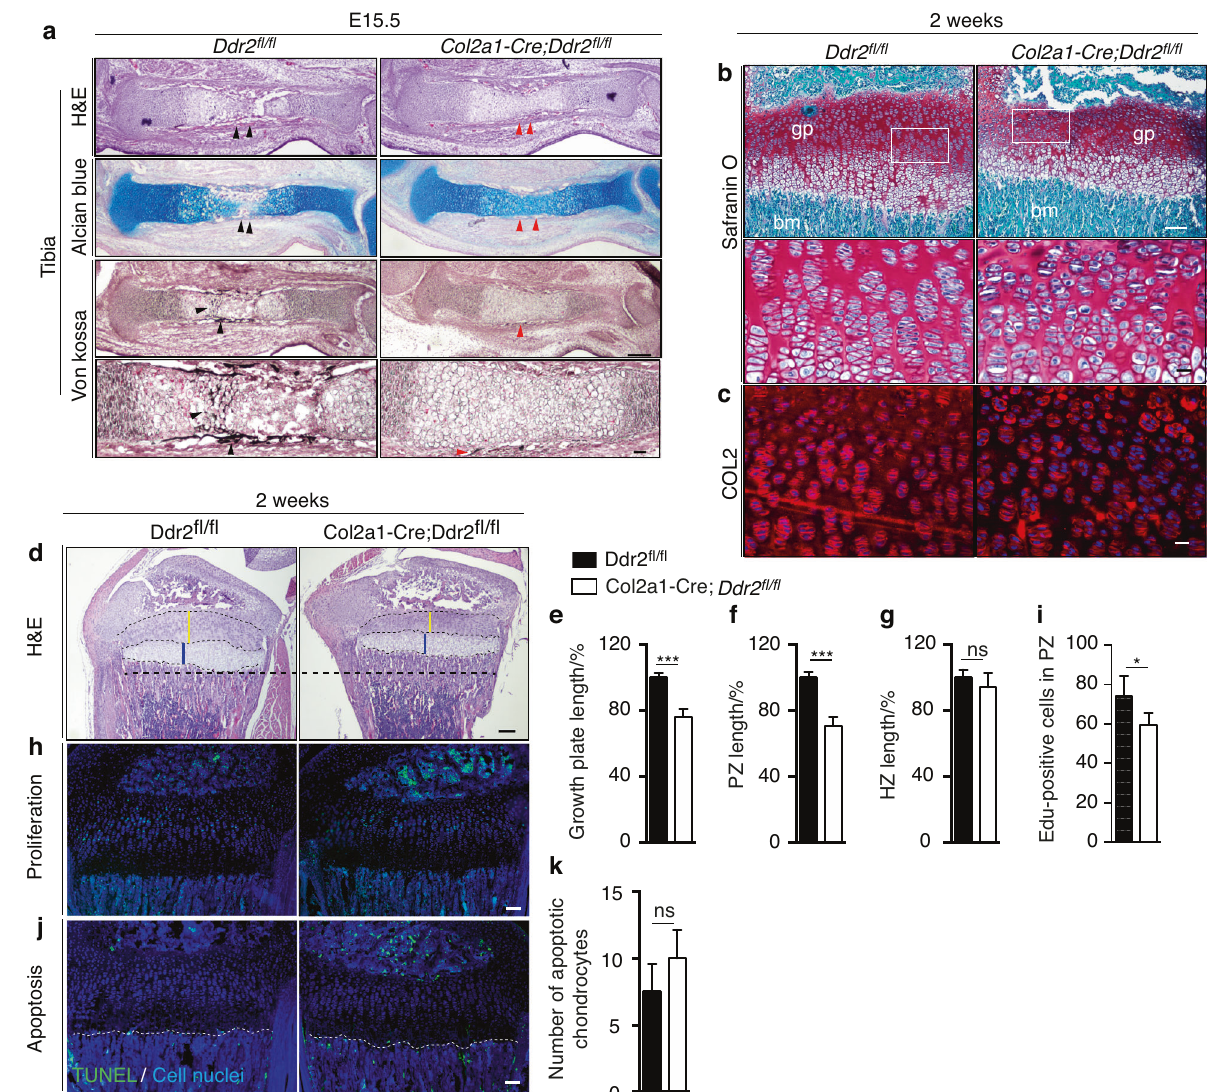
Fig. 6 Ddr2 loss in chondroprogenitor cells results in de fi cient chondrocyte proliferation, organization, and abnormal type II collagen. a Hematoxylin and eosin (H&E), alcian blue and von Kossa staining of developing tibiae at E15.5 showing delays endochondral ossi fi cation in developing skeleton. Red arrowheads point to the delay in the formation of primary ossi fi cation center ( n = 3). Scale bar: 200 μ m and 100 μ m in lower panel. b Safranin O staining of tibial growth plate sections of 2-week-old Col2a1-Cre; Ddr2 fl / fl shows chondrocyte disorganization. Boxed region is shown in higher magni fi cation (bottom). Scale bar: 100 μ m (top) and 20 μ m (bottom). c Immuno fl uorescent staining of tibial growth plate sections of 2-week-old Col2a1-Cre; Ddr2 fl / fl and control littermates with an antibody against type II collagen (red) showing uneven distribution with no immunostaining in between chondrocytes. DAPI (blue) stains cell nuclei. Scale bar: 20 μ m. d – g Hematoxylin and eosin (H&E) staining and quanti fi cation showing reduced growth plate lengths in Col2a1-Cre;Ddr2 fl / fl mice at 2 weeks. Scale bar: 200 μ m. Unpaired t - test *** P < 0.001; ns Not signi fi cant. h EdU staining (green) of tibial growth plate sections show reduced chondrocyte proliferation in Col2a1- Cre; Ddr2 fl / fl mice. Scale bar: 100 μ m. i Quantif i cation of EdU-positive cells in proliferative zone ( n = 4). j Fluorescent TUNEL staining (green) for detecting chondrocyte apoptosis at chondro-osseous junction (dotted lines). DAPI (blue) stains cell nuclei. Scale bar: 100 μ m. k Quanti fi cation of chondrocyte apoptosis ( n = 3), unpaired t -test, ns, not signi fi